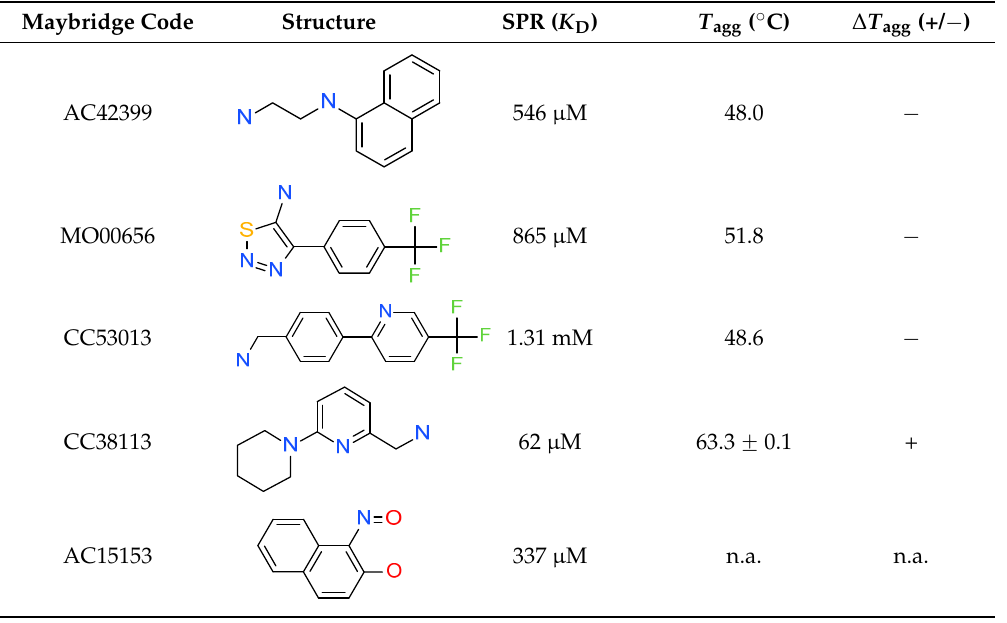
Table 1. Summary of the main fragments identified in this work. Binding and stability data corresponding to 14 compounds (Figures 4 and 6B). Note that, for AC15153, thermal shift data could not be obtained because the protein did not aggregate within the range of temperatures tested. K D values for the last four compounds could not be obtained due to the bad quality of the sensorgrams performed at increasing concentrations. However, they were clearly identified as binders in the primary screening performed at 200 µM (Figure 3). Highlighted are the three compounds with good dose-responses in both SPR and positive (+) Thermal Shift experiments. Values of T agg correspond to protein incubated in 1 mM of each fragment; errors are only given for positive thermal shifts. n.a., not applicable.